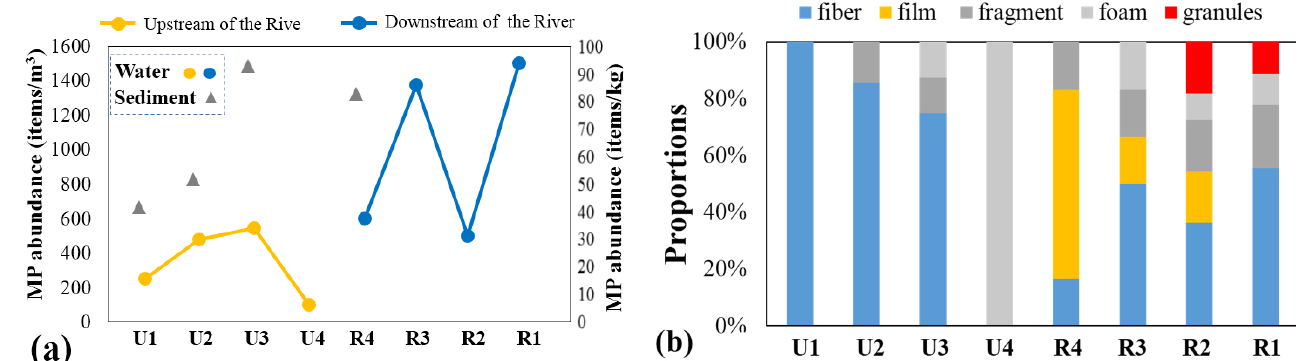
Figure 5. Abundance ( a ) and composition characteristics ( b ) of MPs in different sampling sites from the upper and lower reaches of the Brahmaputra River. Some data (U1, U2, U3, and U4 sites) from [31].